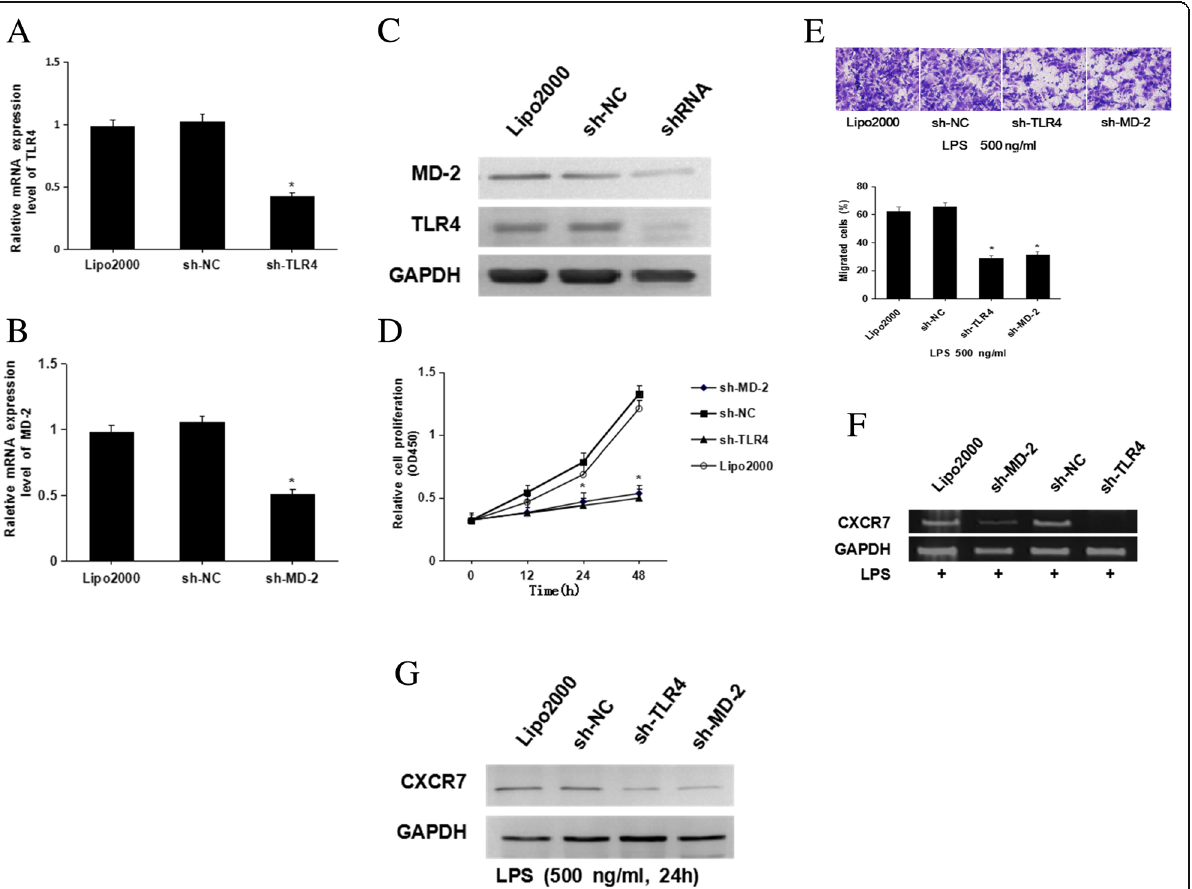
Fig. 3 The effect of TLR4 and MD-2 knockdown on LPS-induced CXCR7 expression. a - c : Gastric cancer cells were transfected with TLR4-specific or MD-2-specific shRNAs, and endogenous TLR4 and MD-2 expression levels were analyzed via qRT-PCR ( a and b ) and western blotting ( c ); d and e : Gastric cancer cells were transfected with TLR4-specific or MD-2-specific shRNAs and treated with 500 ng/mL LPS. A CCK-8 assay was then used to detect cell proliferation ( d ), and a transwell assay was used to assess cell migration ( e ); f and g : As described in D and E, CXCR7 expression was analyzed via RT-PCR (F) and western blotting ( g ) *, P < 0.05, vs. the Lipo2000 group and sh-NC group. The data are presented as the mean ±